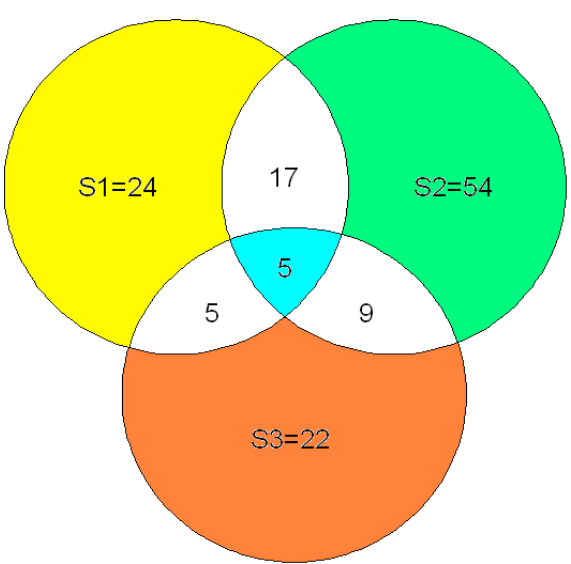
Figure 1. Graphical presentation of all the bird species from the three study sites (SA 1, 2 & 3) based on commonality of occurrence.